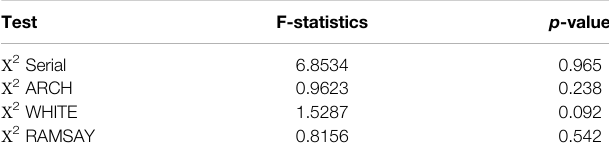
TABLE 7 | Stabiity tests.